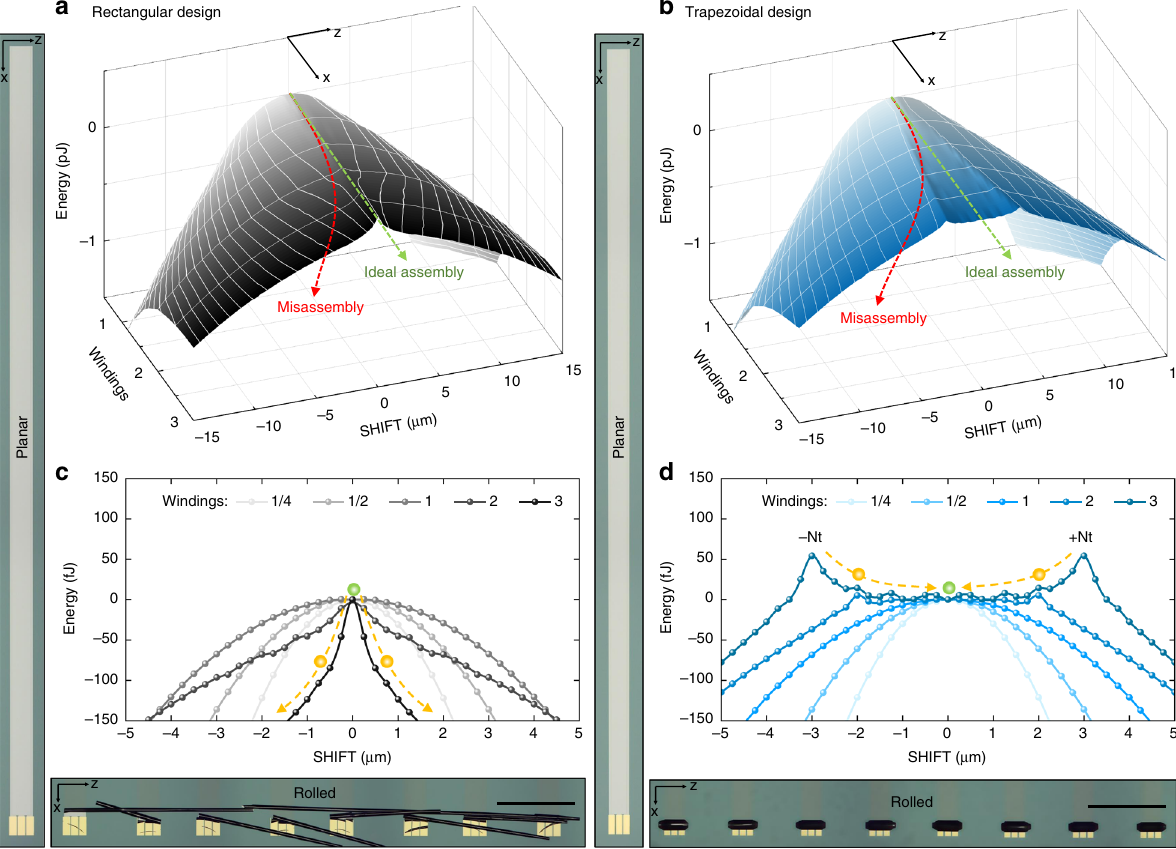
Fig. 3 Shape-dependent behaviour of magnetic nanomembrane. a Magnetostatic free energy surfaces (FES) of rectangular design and corresponding experimental result of the device assembly. b Magnetostatic FES of trapezoidal design with a pitch of 1 µ m/winding and corresponding experimental result of the device assembly. c Cross-sections of the FES in a with increasing number of windings. d Cross-sections of the FES in b with increasing number of windings. Scale bars are 1